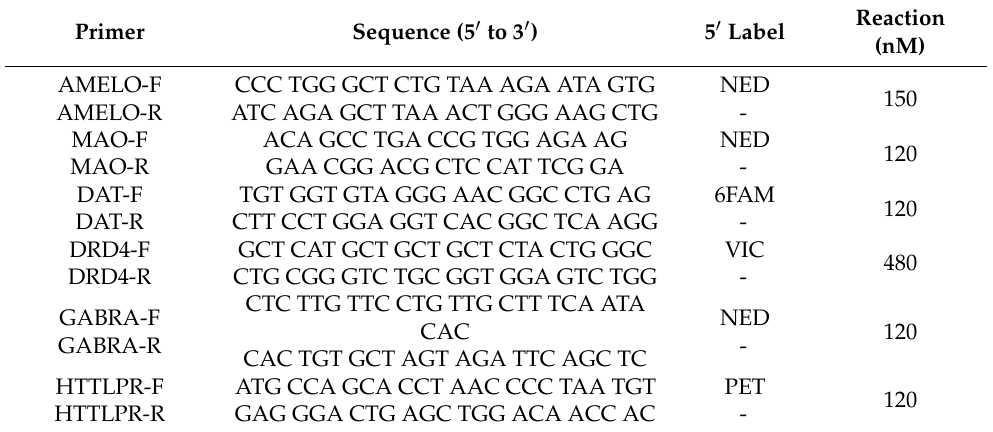
Table 7. GARS repeat primer details.